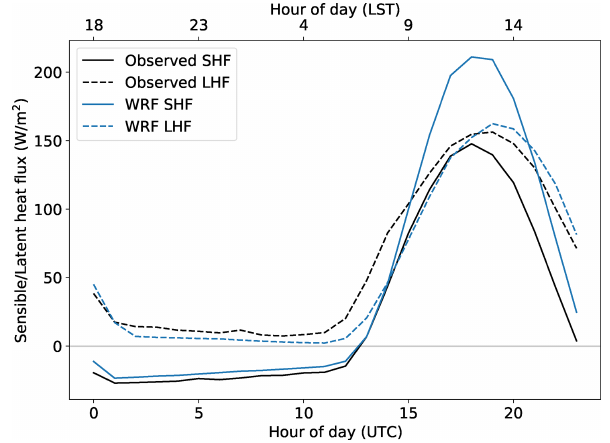
Figure 12. Observed and WTK-LED-modeled average diurnal cy- cle of sensible and latent heat fluxes at the SGP